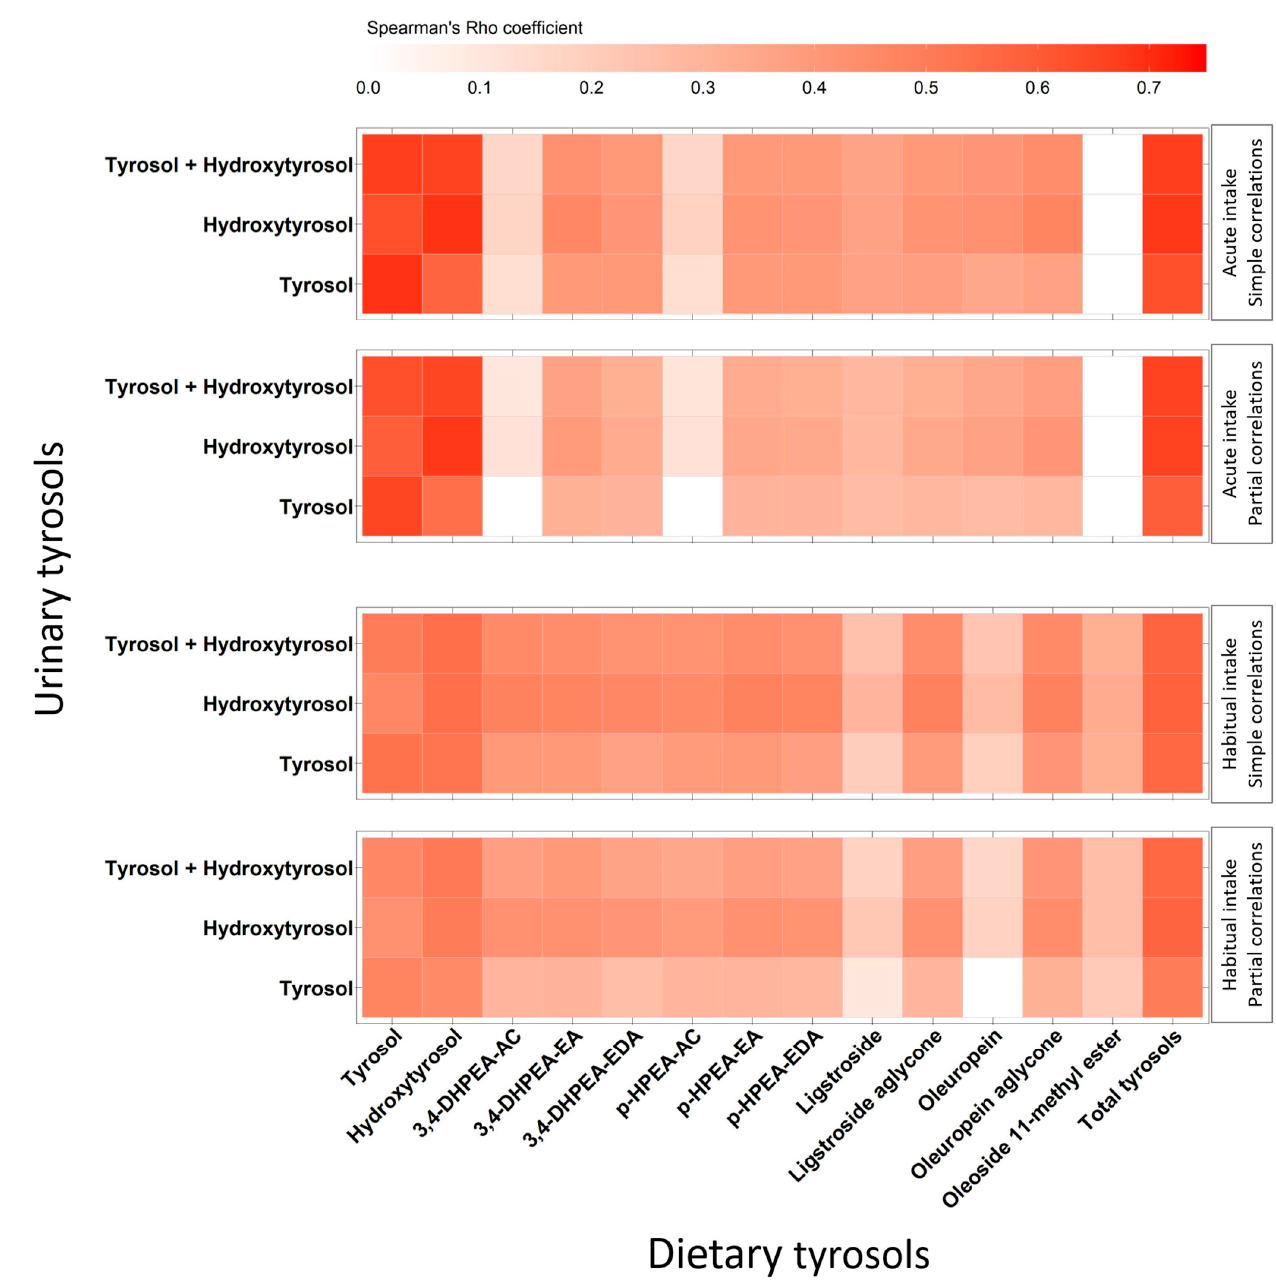
Figure 1. Heatmaps showing simple and partial Spearman’s correlations between urinary excretion and dietary intake (acute and habitual) of tyrosols. Abbreviations: 3,4-DHPEA-AC, hydroxytyrosol acetate; 3,4-DHPEA-EA, oleuropein-aglycone mono-aldehyde; 3,4-DHPEA-EDA, oleuropein-aglycone di-aldehyde; p-HPEA-AC, tyrosol acetate; p-HPEA-EA, ligstroside-aglycone mono-aldehyde; p-HPEA-EDA, ligstroside-aglycone di-aldehyde.